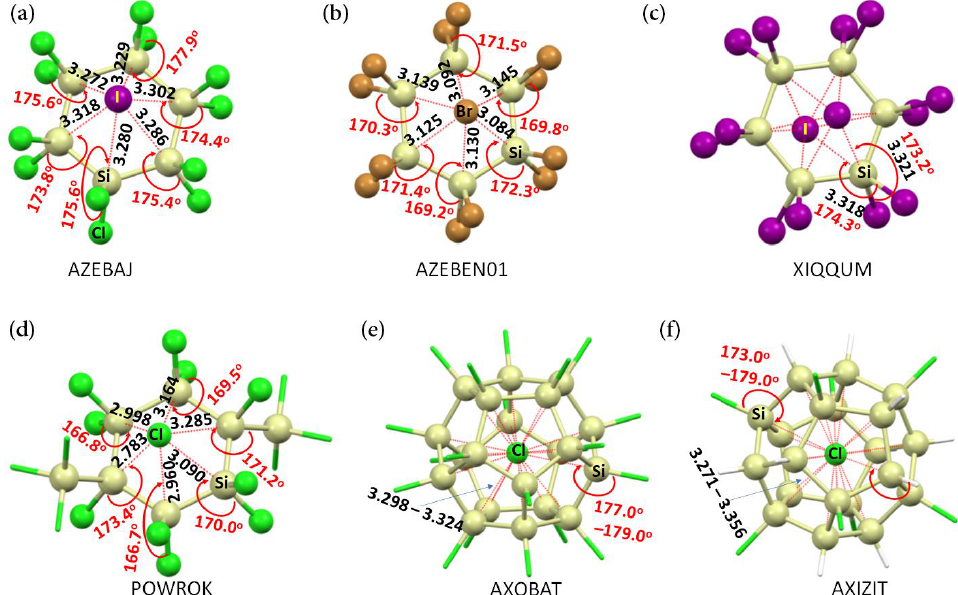
Figure 1. Illustration of molecule – anion interactions in the anionic part of some selected chemical systems cataloged in the CSD [9]. The crystals include: ( a ) bis(tetrabutylammonium) dodecachlorohexasilinane bis(iodide) dichloromethane solvate [2(C 16 H 36 N + ),Cl 12 Si 6 ,CH 2 Cl 2 ,2(I − )] [12]; ( b ) bis(tetrabutylammonium) bis(bromide) dodecabromohexasilinane [2(C 16 H 36 N + ),Br 12 Si 6 ,2(Br − )] [13]; ( c ) bis(tetrabutylphosphanium) dodecaiodohexasilinane bis(iodide) [2(C 16 H 36 P + ),I 12 Si 6 ,2(I − )] [13]; ( d ) bis(tetraphenylphosphonium) 1,1,2,2,3,4,4,5,5,6-decachloro-3,6-bis(trichlorosilyl)hexasilinane bis(chloride) [2(C 24 H 20 P + ),Cl 16 Si 8 ,2(Cl − )] [14]; ( e ) triphenyl-N-(triphenylphosphanylidene)phosphaniminium chloride 1,2,3,4,5,6,7,8,9,10,11,12,13,14,15,16,17,18,19,20-icosachloroundecacyclo [9.9.0.0 2,9 .0 3,7 .0 4,20 .0 5,18 .0 6,16 .0 8,15 .0 10,14 .0 12,19 .0 13,17 ]icosasilane chloroform solvate [C 36 H 30 NP 2+ ,Cl 20 Si 20 ,2(CHCl 3 ),Cl − ] [15]; ( f ) bis(triphenyl-N-(triphenylphosphanylidene)phosphaniminium) chloride 4-methylbenzene-1-sulfonate 1,3,5,8,10,13,16,19-octachloroundecacyclo [9.9.0.0 2,9 .0 3,7 .0 4,20 .0 5,18 .0 6,16 .0 8,15 .0 10,14 .0 12,19 .0 13,17 ]icosasilane [2(C 36 H 30 NP 2+ ),H 12 Cl 8 Si 20 ,C 7 H 7 O 3 S − ,Cl − ] [15]. The CSD reference codes are depicted in uppercase letters. Selected bond distances and bond angles associated with the (H−)Si···Cl and/or (X−)Si···X (X = Cl Br, I) contacts are in Å and degree, respectively. Atom labeling is shown for selected atoms.